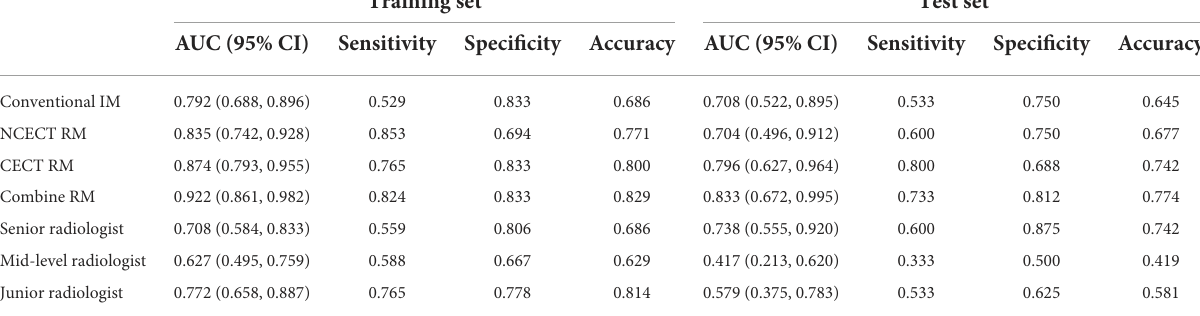
TABLE 3 Diagnostic efficiency of four models and three